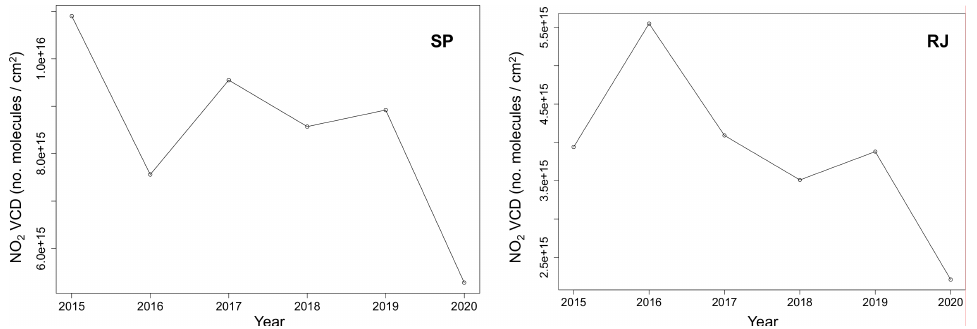
Figure 6. Yearly time-series of mean NO 2 VCDs for the satellite grid cells covering the selected SP and RJ ground